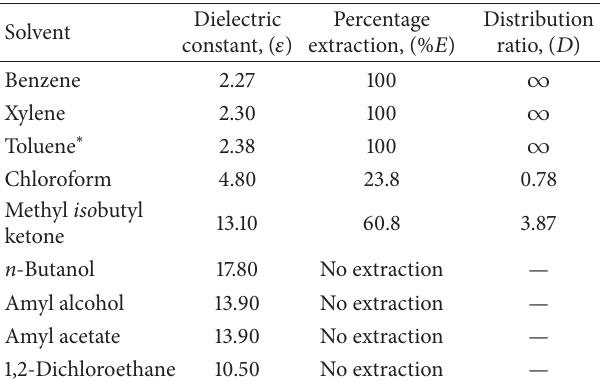
Table 1: Extraction behaviour of platinum(IV) as a function of diluents. (Pt(IV) = 150 𝜇 g, Aq :Org = 2.5 :1, pH = 0.50, ascorbic acid = 0.01M, equilibrium time = 3min, and strippant = water ( 2 × 10